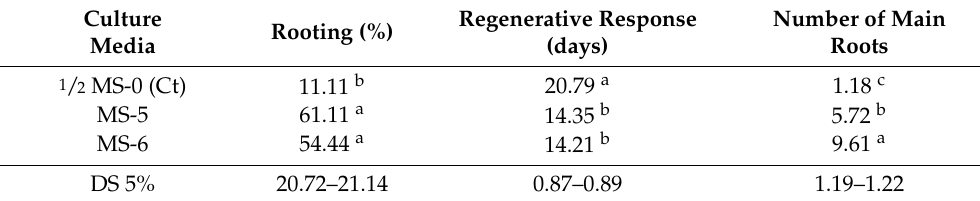
Table 8. Culture medium influence on P. quadrangularis